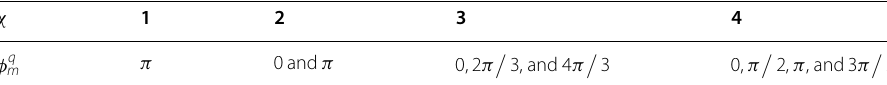
Table 2 Relationship between χ and φ q